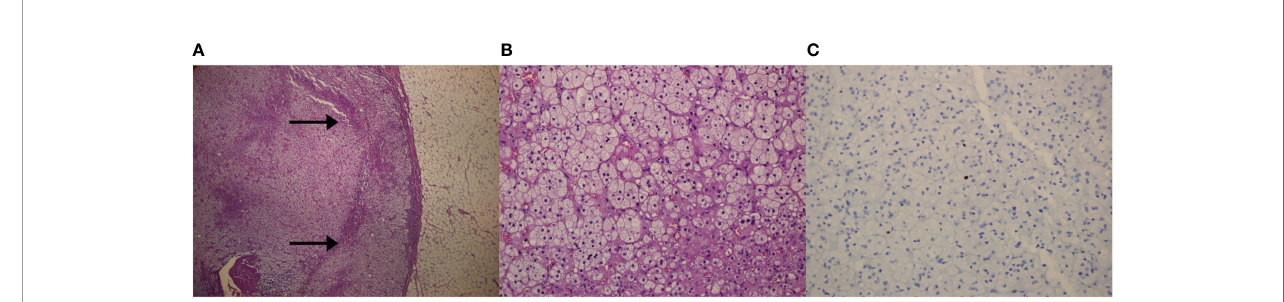
FIGURE 2 | Microscopic images of the left adrenal gland. (A) Panoramic microscopic image of the larger nodule (Hematoxylin – Eosin; magni fi cation ×4). Lack of capsule and fear delimitation of the normal cortex (arrows). (B) Representative histologic section of the adenomatous left adrenal hyperplasia, showing two types of cell population. No atypia, mitosis or necrosis was detected (Hematoxylin – Eosin; magni fi cation ×20). (C) Positive Ki-67 immunohistochemical staining in less than 1% of adrenal cells (magni fi cation ×20).